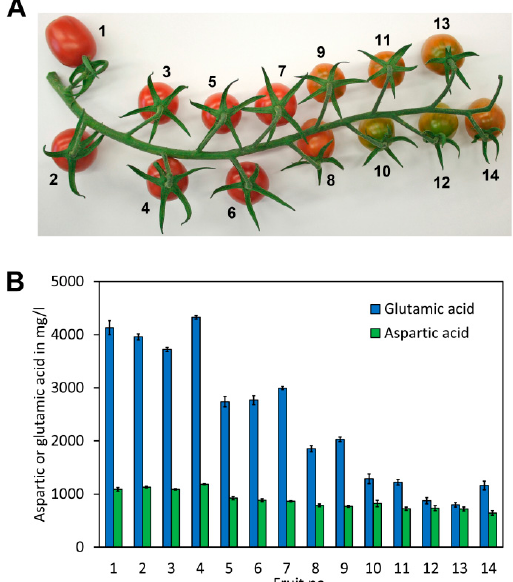
Figure 5. Analysis of glutamate and aspartate in different ripening stages of cherry tomato. ( A )